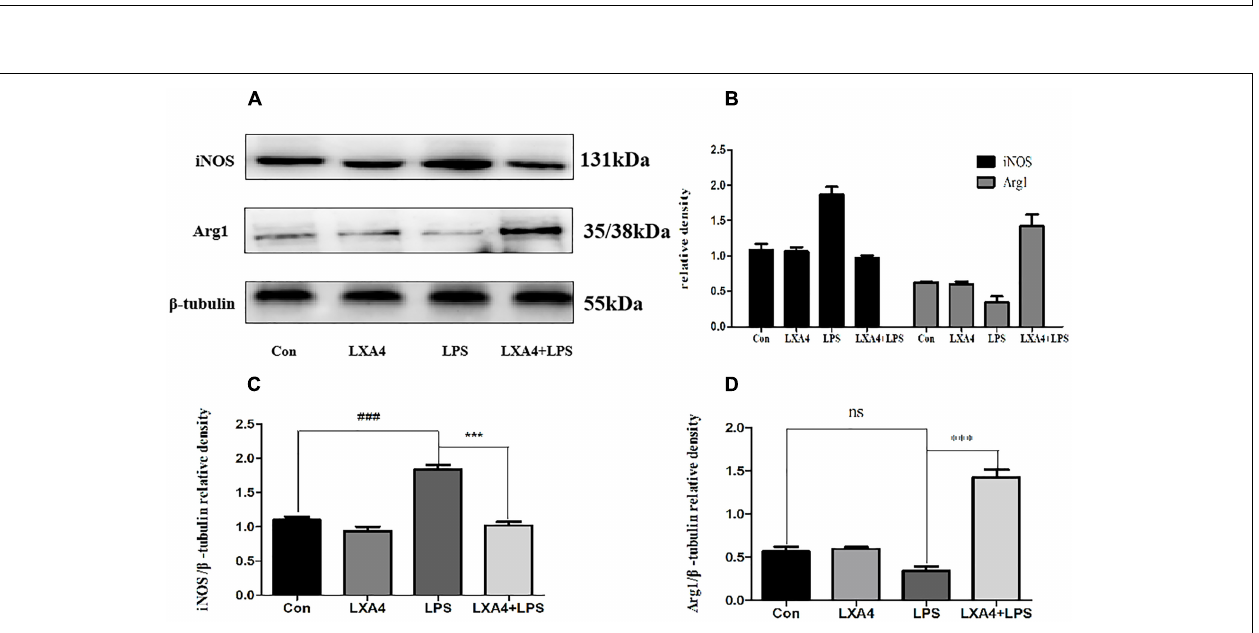
Frontiers in Cellular Neuroscience |